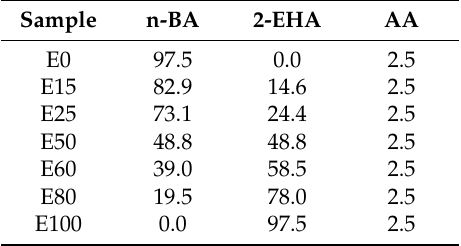
Table 1. Monomer composition (phm) of the